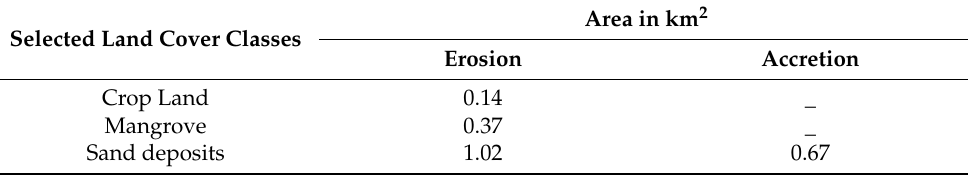
Table 3. Erosion-Accretion scenario across the estuarine section of Subarnarekha River. Selected Land Cover Classes